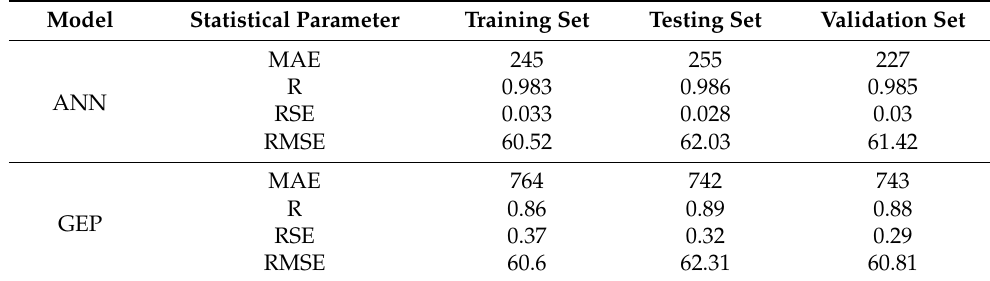
Table 5. Statistical evaluation of the developed